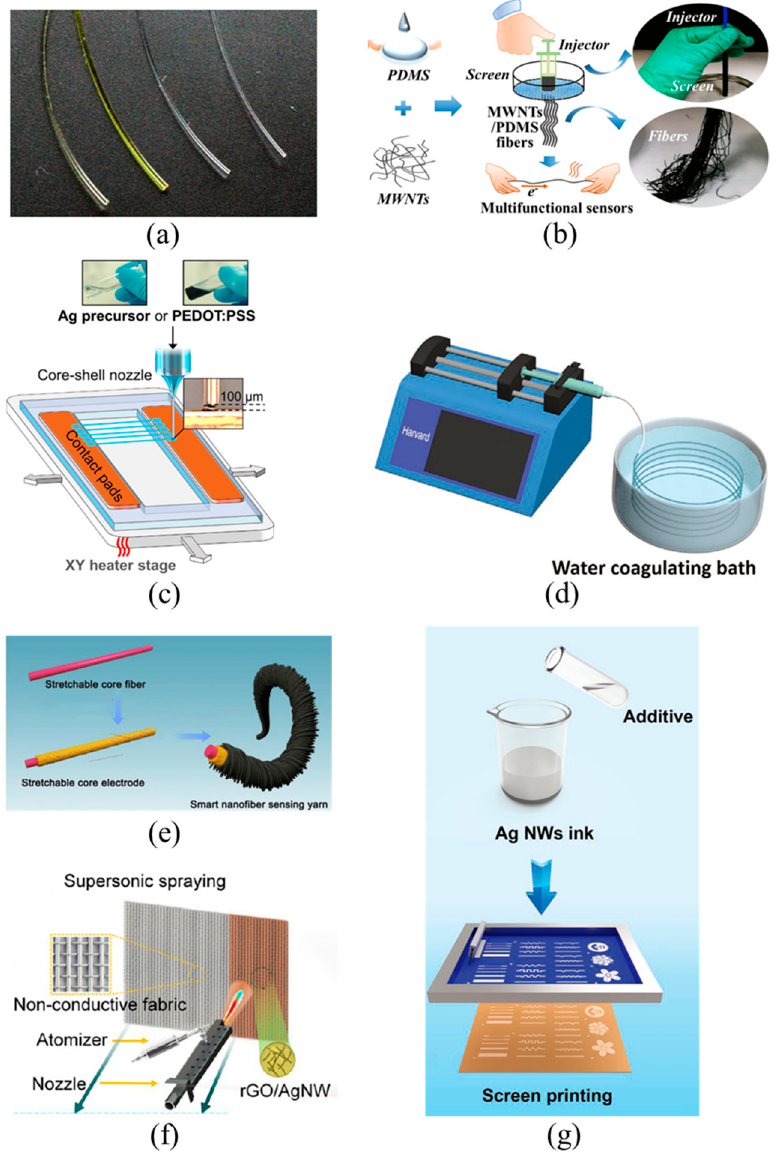
Figure 1. Illustration of the manufacturing process of various resistive textile-based mechanical sensors (TMSs). PDMS means polydimethylsiloxane, MWNTs means multi-walled carbon nanotubes, PEDOT:PSS means poly(3,4-ethylenedioxythiophene)/poly(styrenesulfonate), rGO means reduced graphene oxide and AgNWs means silver nanowires. Fiber-based sensors prepared by ( a ) coating, reproduced with permission from [35]; ( b ) extrusion, reproduced with permission from [36]; ( c ) printing, reproduced with permission from [37]; and ( d ) wet spinning, reproduced with permission from [38]; ( e ) Yarn-based sensors prepared by electrostatic spinning, reproduced with permission from [39]; Fabric-based sensors prepared by ( f ) spraying, reproduced with permission from [41]; and ( g ) screen printing, reproduced with permission from ref. [42].